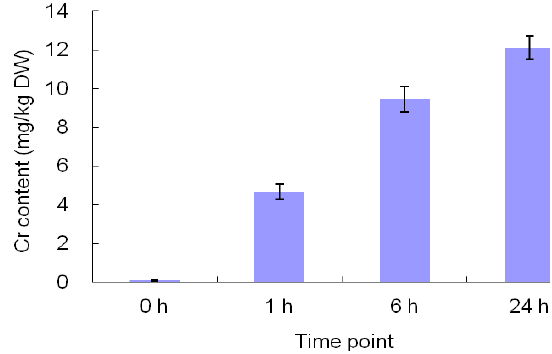
Figure 1. Effects of Cr treatment on Cr content of maize leaves. Maize seedlings were watered with 300 mg/L potassium dichromate solution for 24 h and the Cr concentrations of leaves were measured at the time point 0 h (prior to treatment), 1 h, 6 h and 24 h. The Cr levels are mean values ±